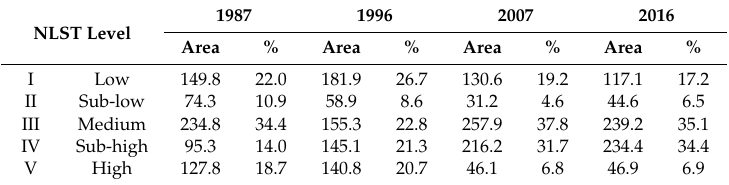
Table 2. Area statistics of di ff erent NLST levels in 1987, 1996, 2007 and 2016 in Wuhan (km 2 ).